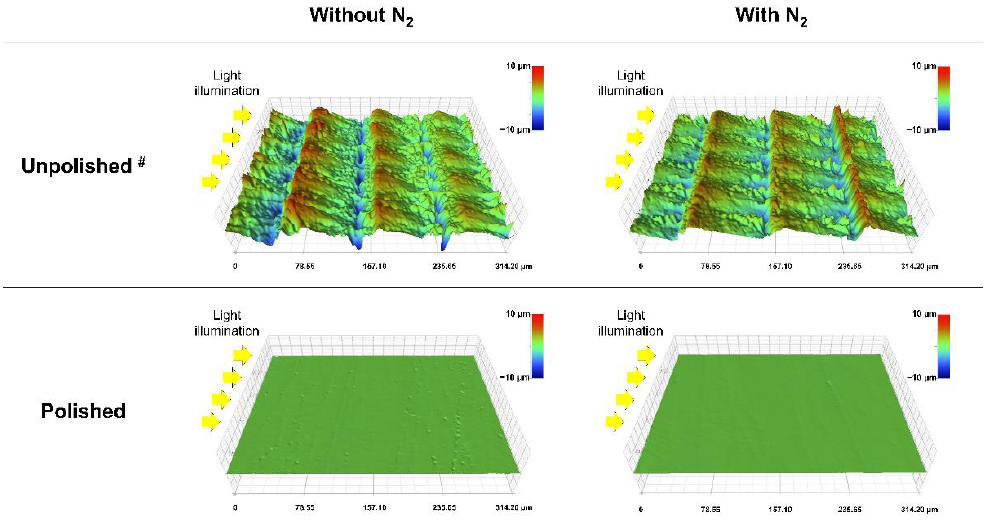
Figure 7. Optical profilometer (OP) images in typical specimens. The yellow arrows represent the light illuminating direction. It was noted that the wavelike structures with a height of less than 10 µm were observed only in polished specimens and there was no difference between specimens post-cured without and with N 2 . # : images of unpolished subgroups were quoted from the previous study [19].